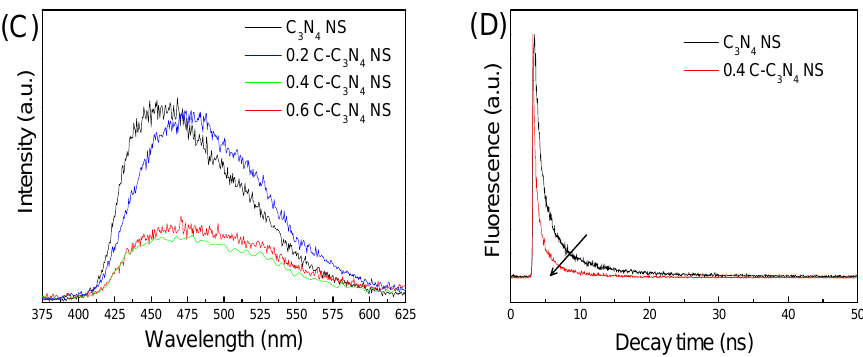
Figure 7. ( A ) Photoinduced current–time curves and ( B ) Electrochemical impedance spectroscopy (EIS) results of C 3 N 4 NS and 0.4 C ‐ C 3 N 4 NS electrodes. ( C ) Photoluminescence spectra of series of samples. ( D ) Time ‐ resolved fluorescence spectra of C 3 N 4 NS and 0.4 C ‐ C 3 N 4 NS.